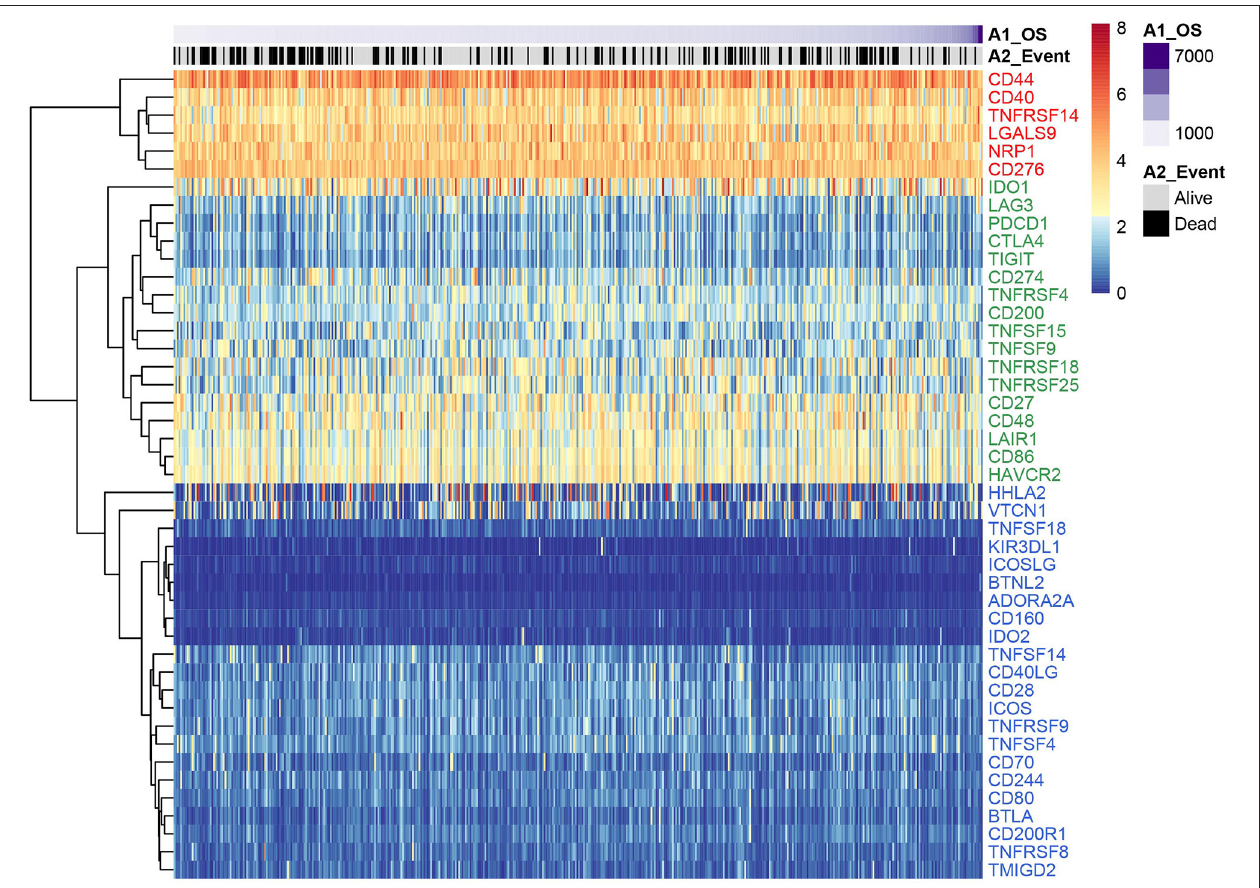
FIGURE 1 | Unsupervised clustering of ICGs in the TCGA-LUAD cohort. The overall survival and status event were used as patient annotations. Red: high expression group; green: medium expression group; blue: low expression